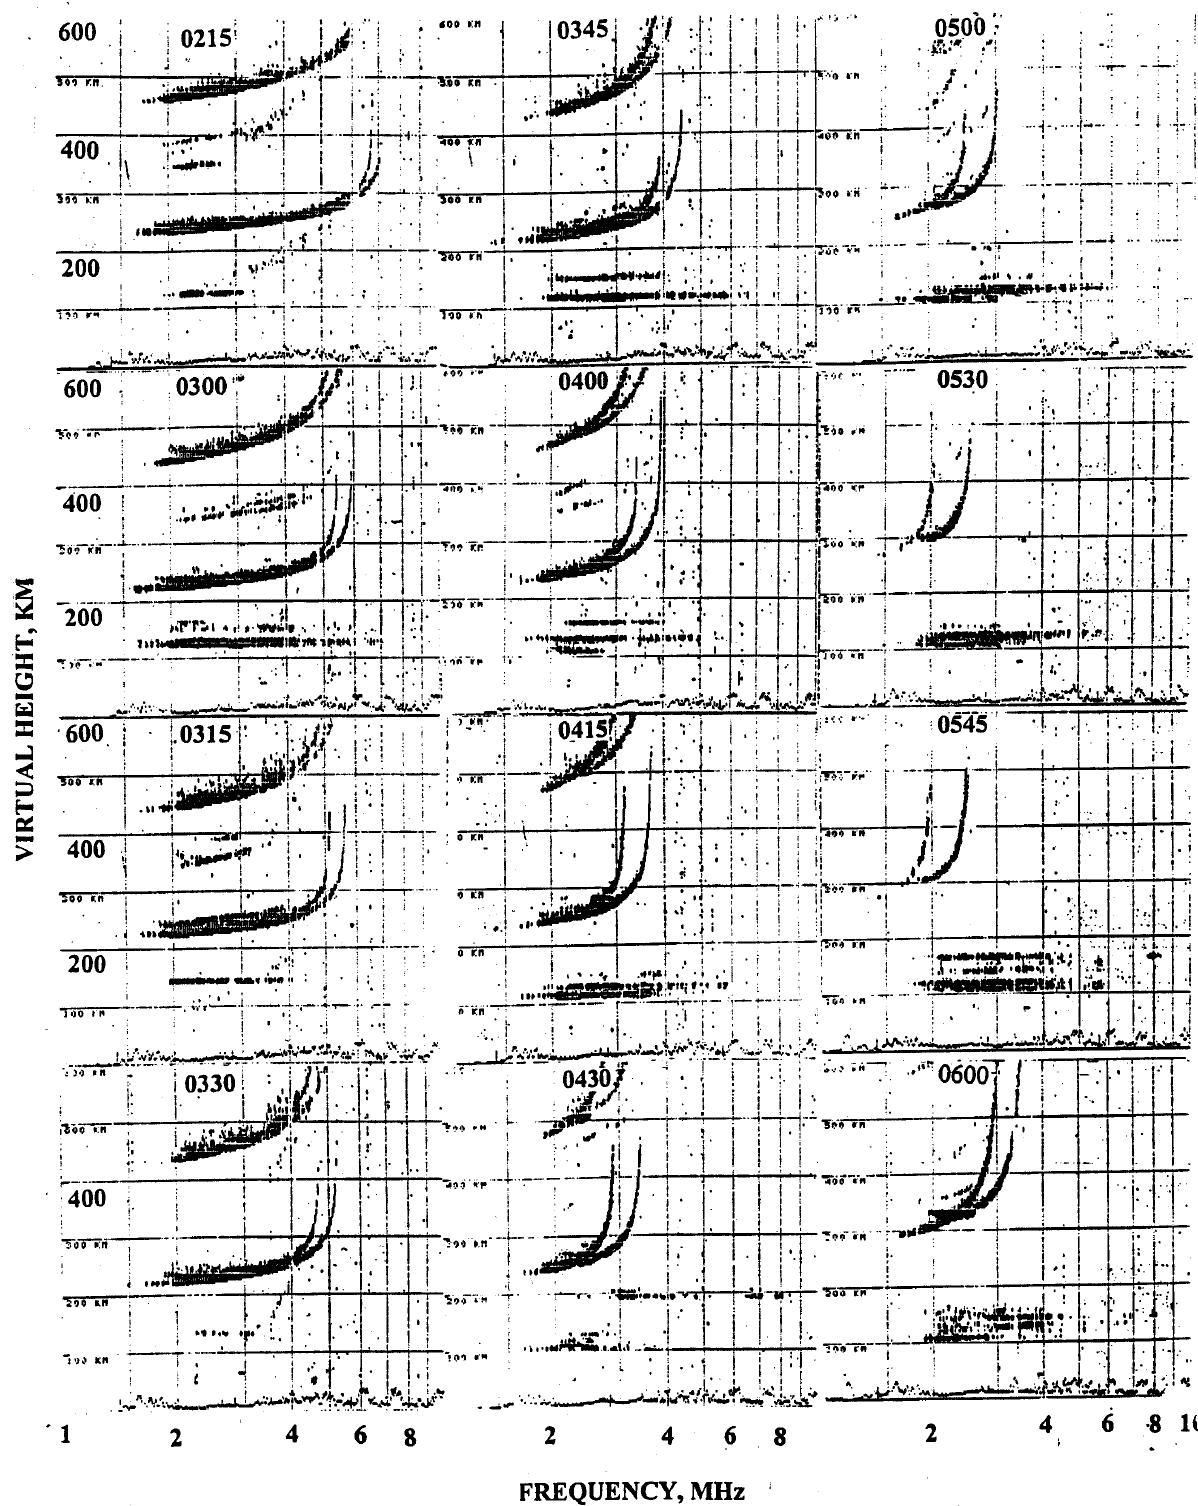
Fig. 8. Selected ionograms over Thumba from 0215h to 0600h of 17 November 1998 showing the development of sporadic-E associated with Leonid shower